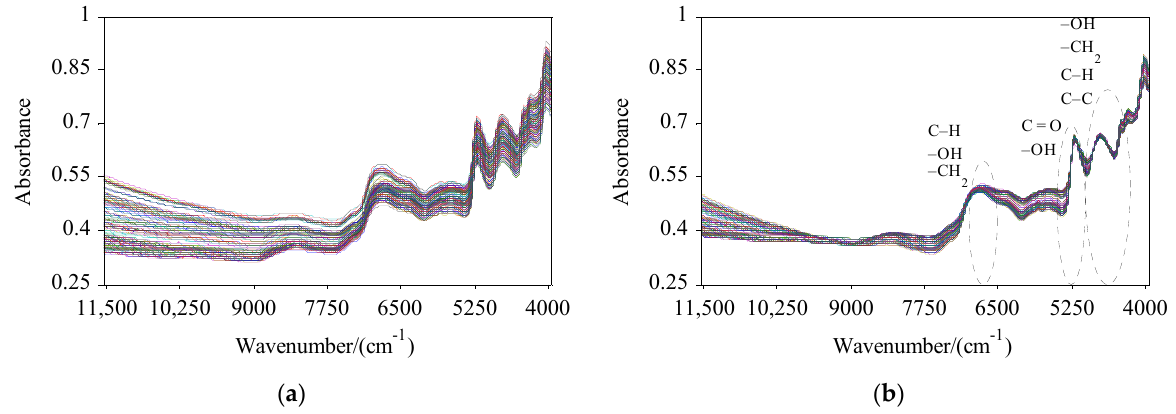
Figure 1. Near-infrared reflectance spectra of all samples: ( a ) raw spectra of all samples; ( b ) pre- processed spectra of all samples .